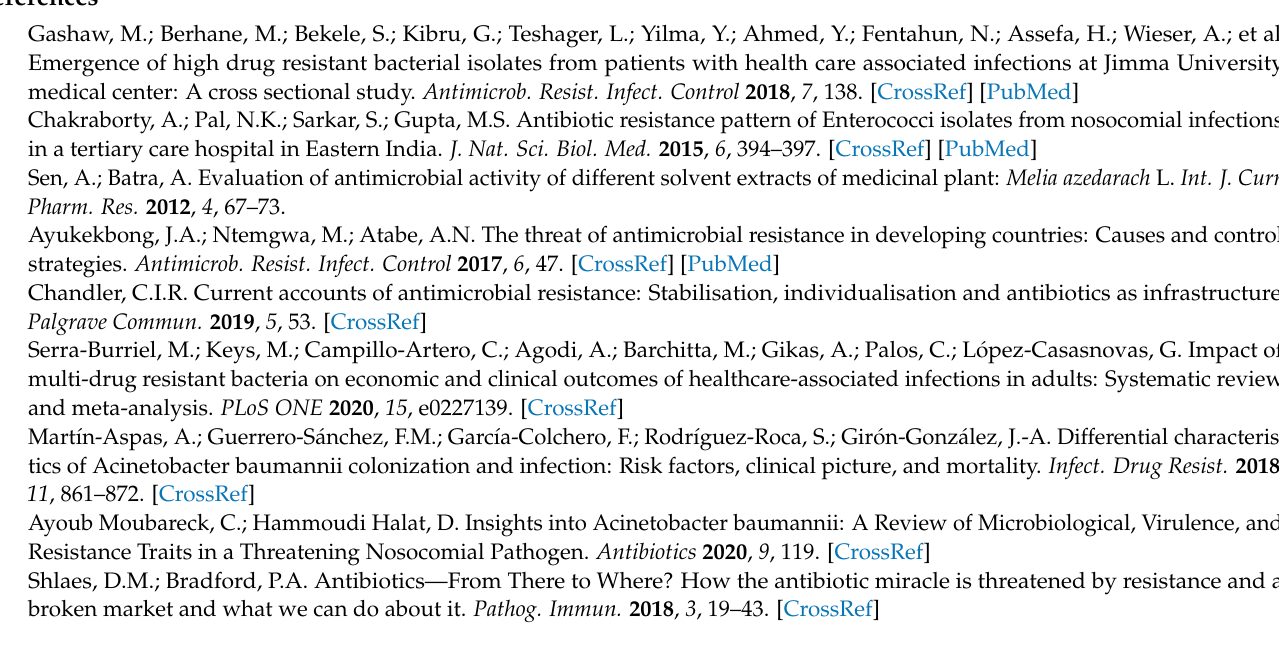
Table S2: Thermocycling condition used in the study